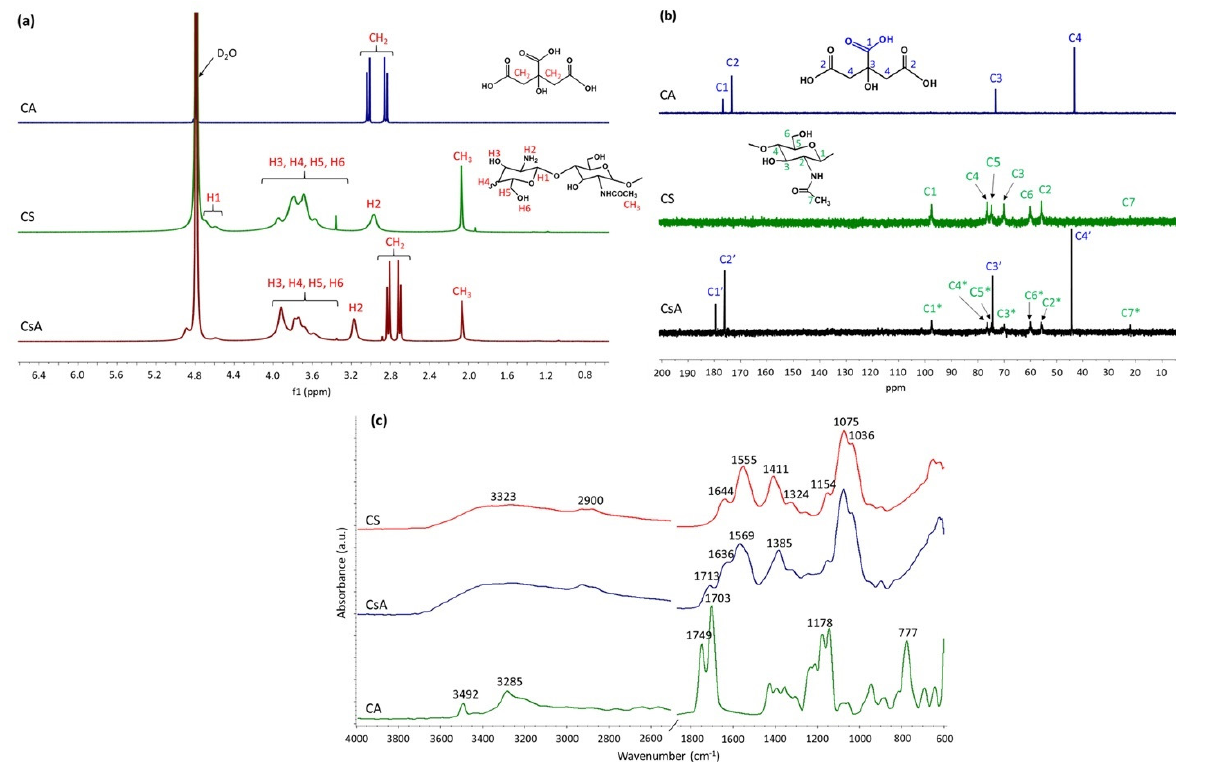
Figure 2. Structural characterization of CsA: ( a ) 1 H-NMR spectra of CA, CS, and CsA in D 2 O/HCl at 25 °C. ( b ) 13 C-NMR spectra of CA, CS, and CsA in D 2 O/HCl at 25 °C. ( c ) ATR-FTIR spectra of CA, CS, and CsA.